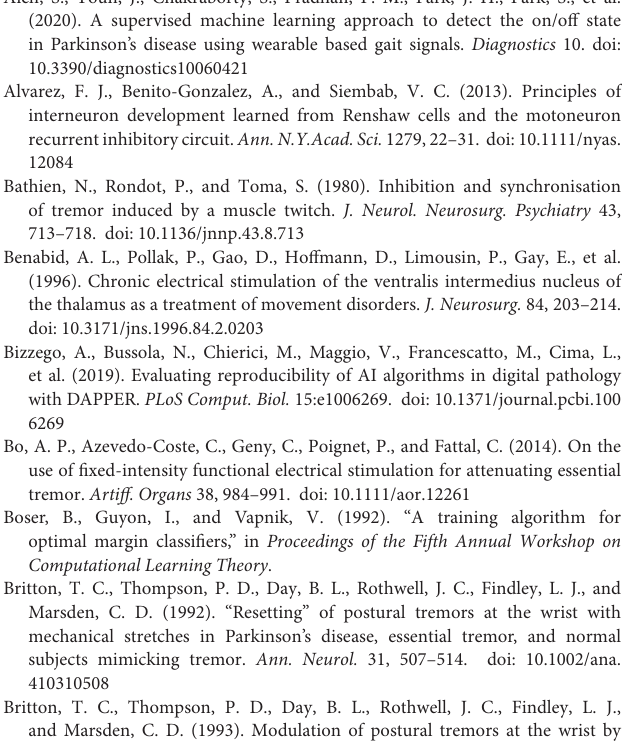
Supplementary Material 2 | A TREND checklist. Supplementary Material 3 | Sample size